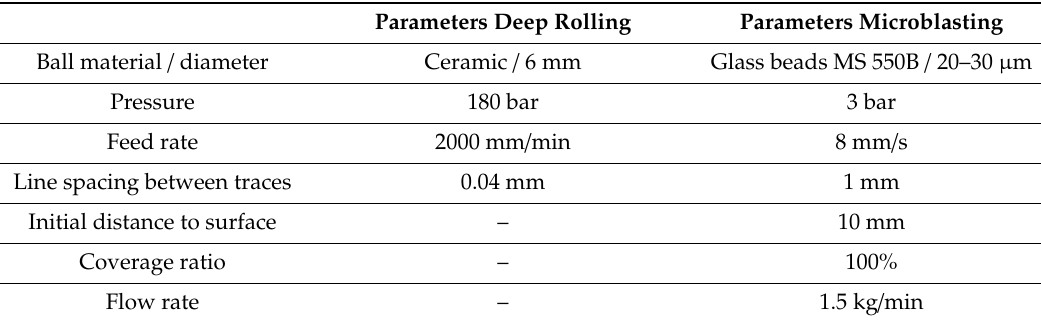
Table 1. Processing parameters applied for deep rolling and